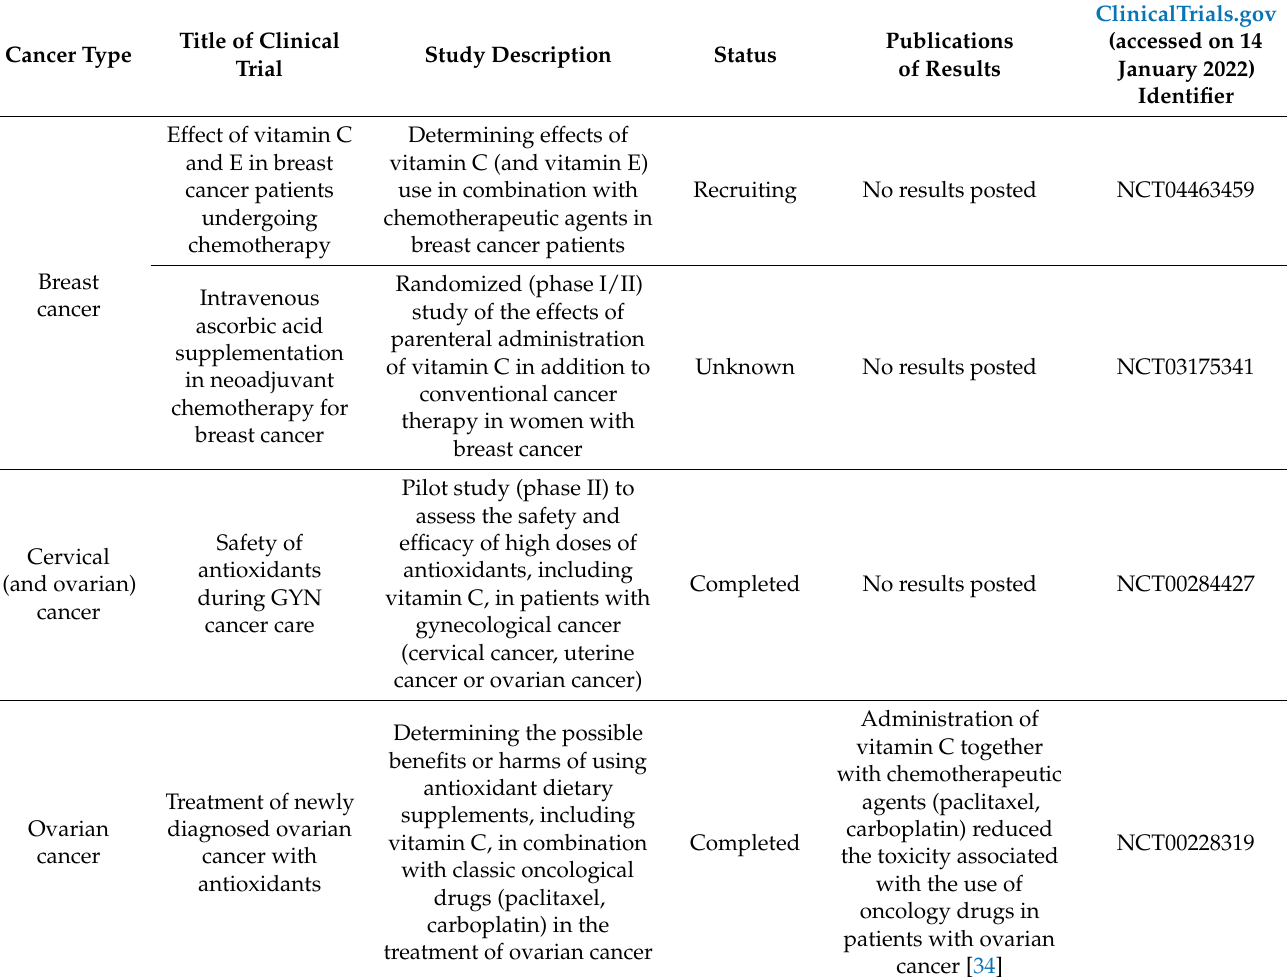
Table 3. Ongoing and completed clinical trials with vitamin C in selected malignant neoplasms in women (ClinicalTrials.gov; online accessed on 14 January